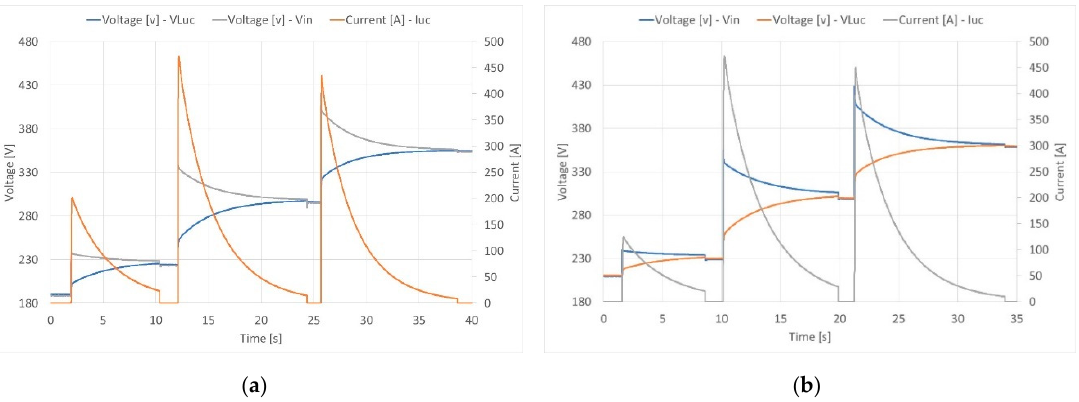
Figure 6. Charging process with on board initial voltage of: ( a ) 190 V, ( b ) 210V.